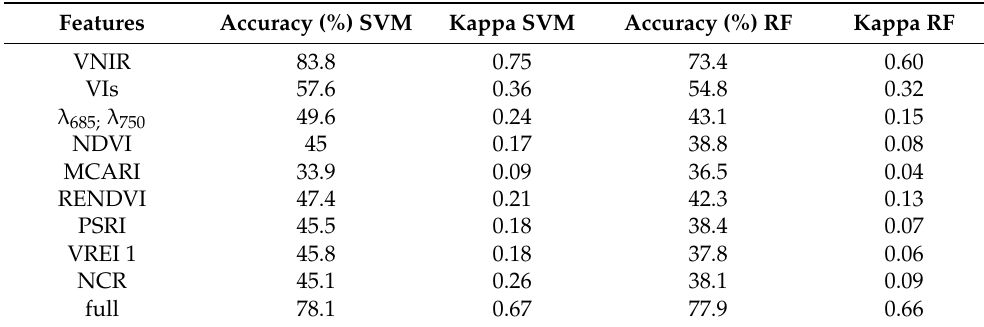
Table 4. Overall accuracy (OA) and Kappa statistic and the associated features used with the SVM and RF classification algorithm.